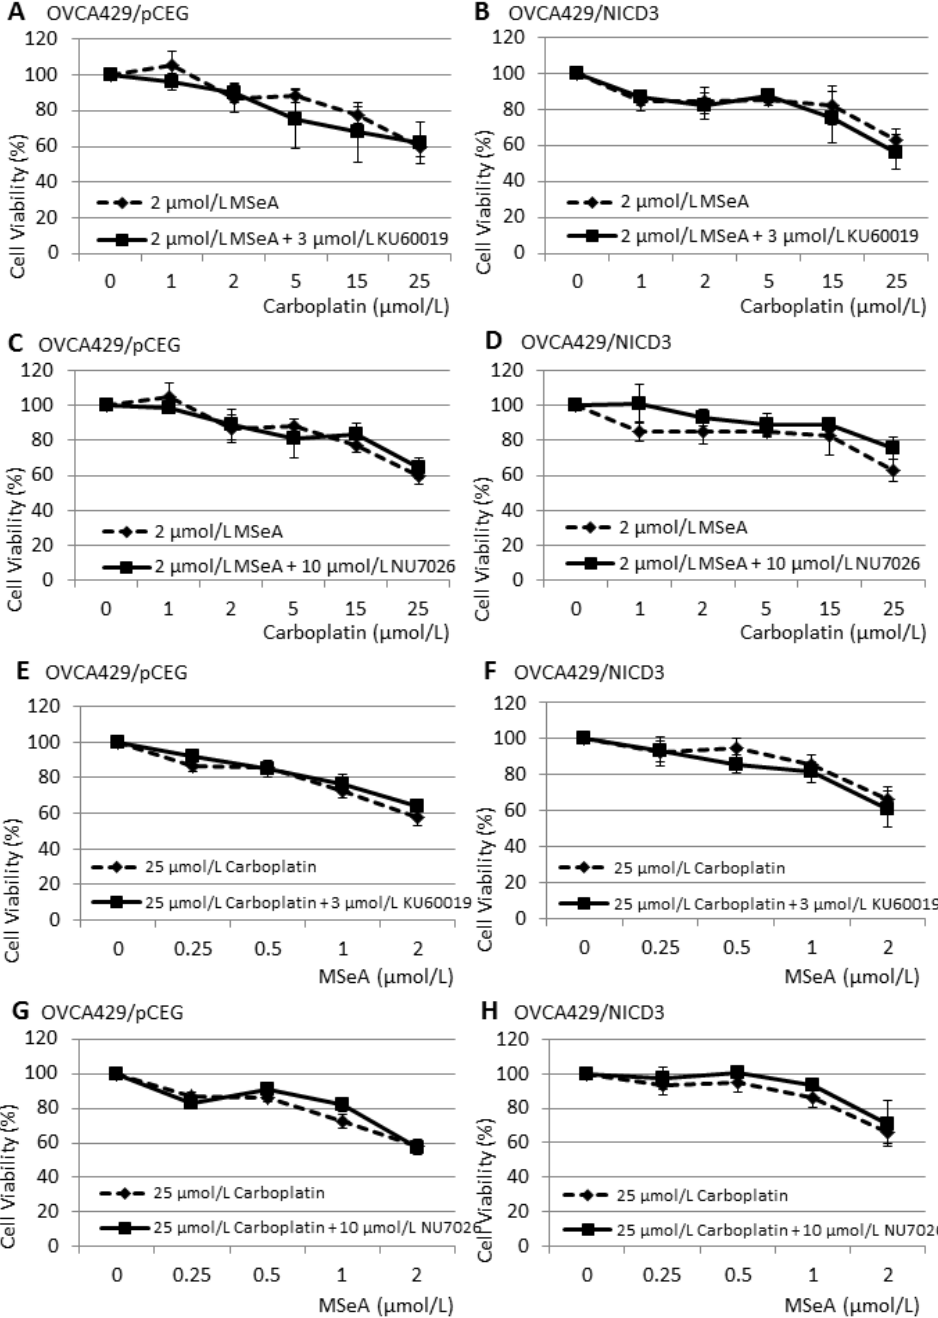
Figure 3. The effect of KU 60019 and NU 7026 on the sensitivity of OVCA429/pCEG and OVCA429/NICD3 cells to MSeA and carboplatin co-treatment. Cells were treated with MSeA and a gradient of carboplatin ( A – D ) or carboplatin and a gradient concentration of MSeA ( E – H ) in the presence or absence of KU 60019 ( A , B , E , F ) and NU 7026 ( C , D , G , H ). Cell viability was determined by SRB assay. Values are mean 6 S.E.M. (n =